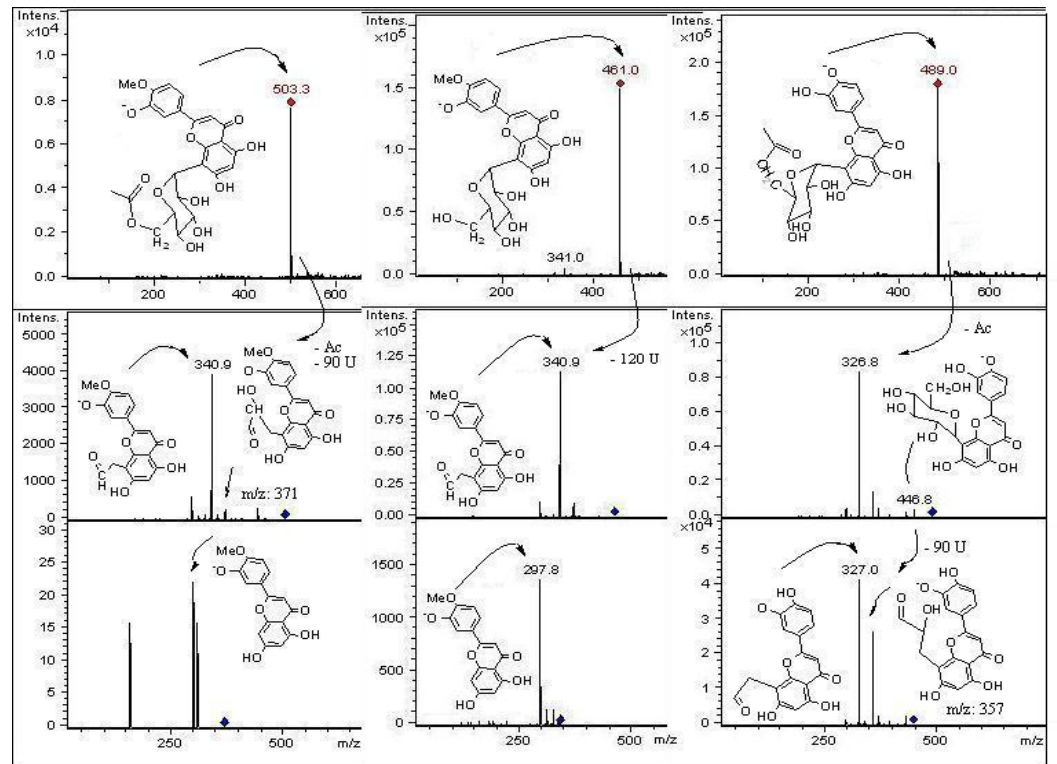
Figure 5. Structures, fragmentation, Full ESI-MS and MS-MS spectra of peaks 31, 21 and